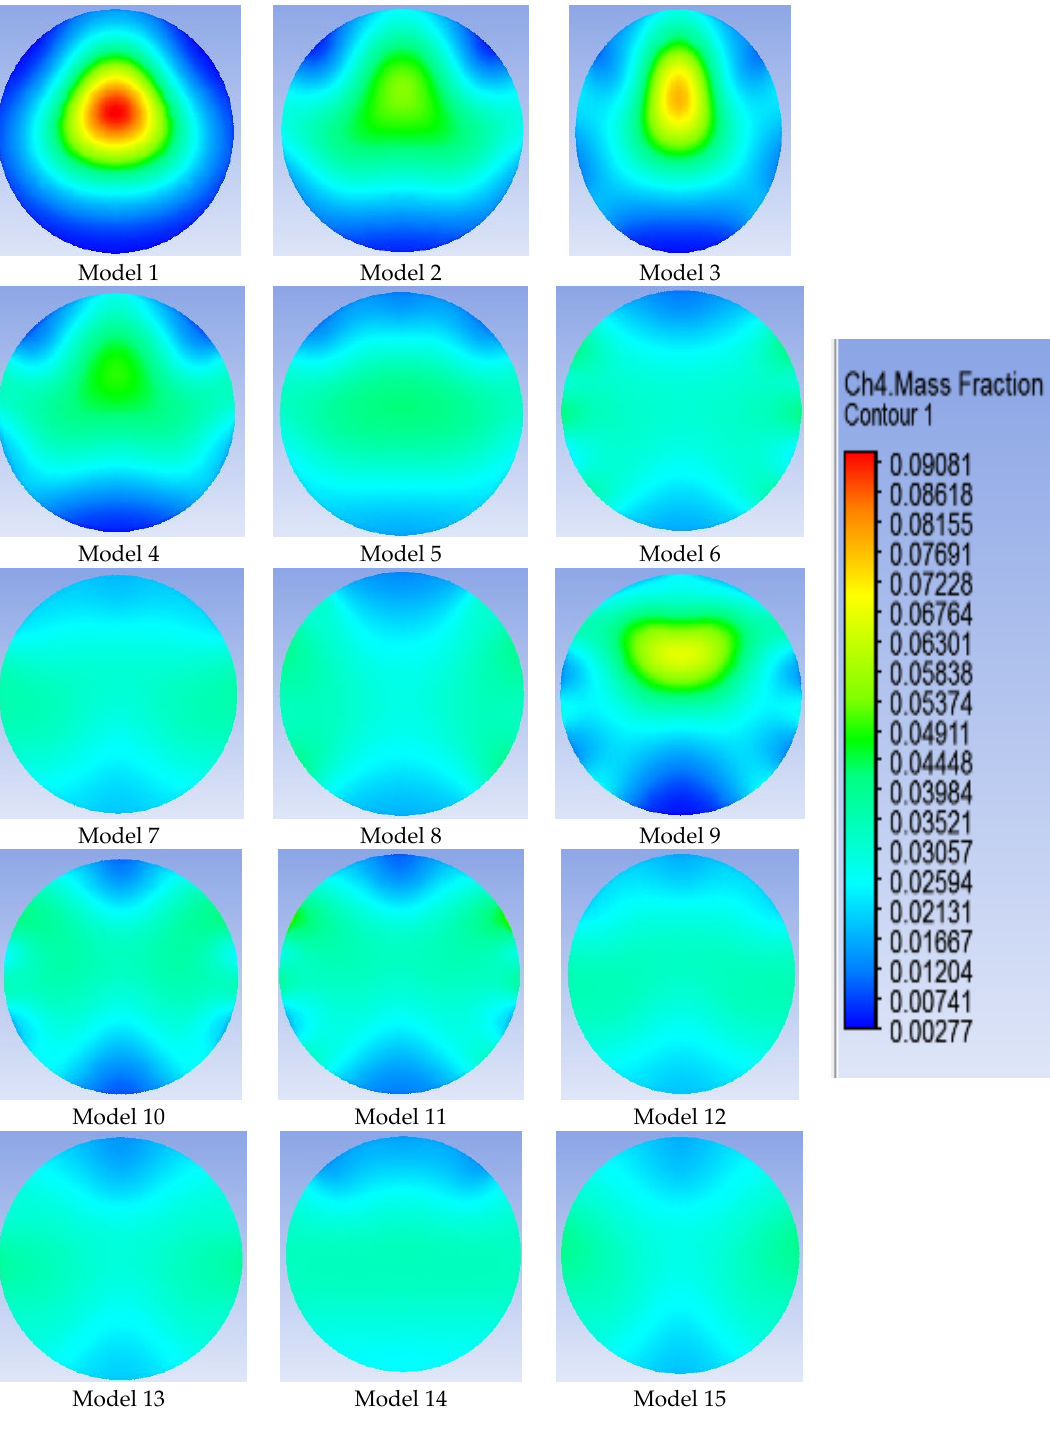
Figure 16. User-defined methane mass fraction contour at outlet of the existing mixer and new mixer models (best case for each model) under air-CNG ratio 34.15